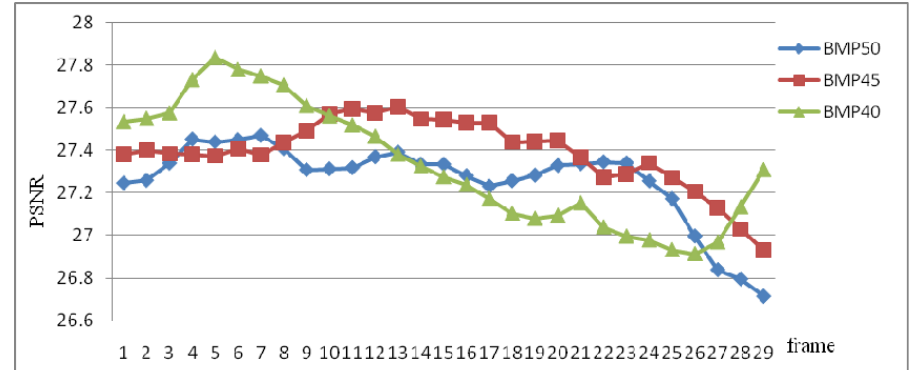
Figure 12. The chart of PSNR values of 29 sub-frames of backward middle parking video with θ = 50, 45 and 40